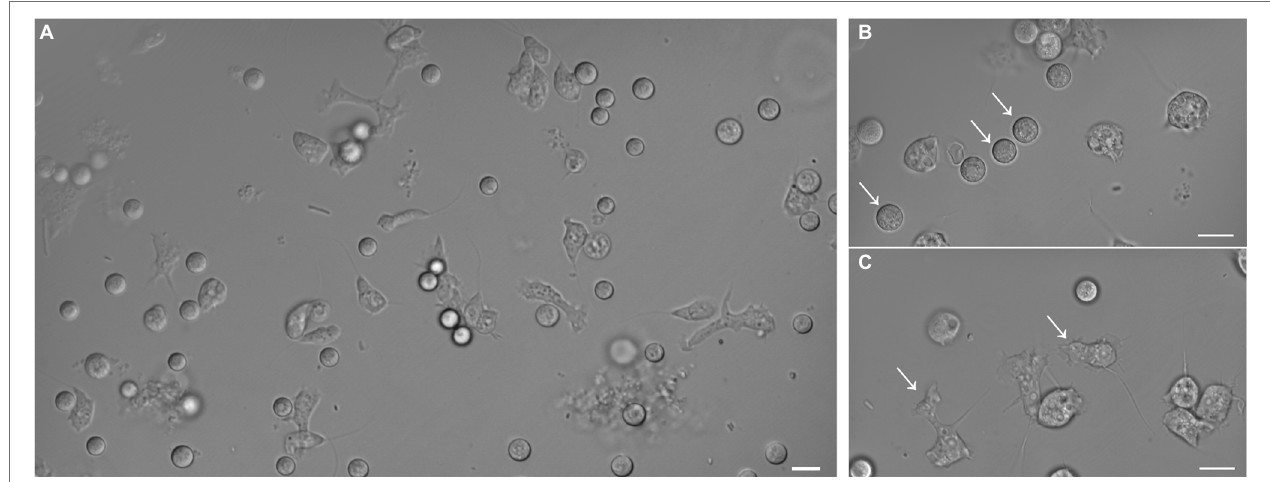
FIGURE 2 | Differential interference contrast micrographs of isolated amoeba. Images show morphology features highlighting the diversity of shapes and sizes of the isolated amoeba. (A) Global view of the different shapes of amoebae. Panels (B) and (C) focus on rounded (arrows) and flagellated (arrows) amoebae, respectively. The bar length represents 10 µm for all